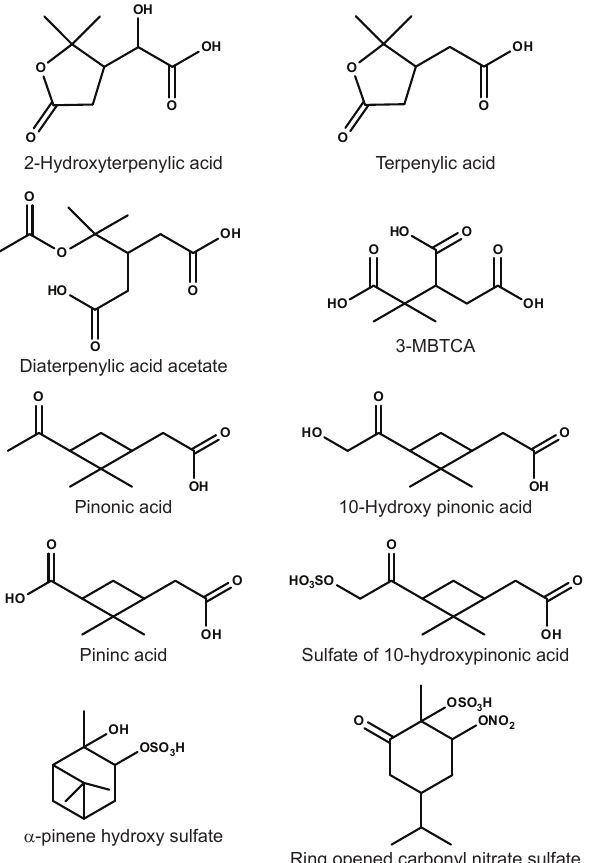
Fig. 4. Structures of identified SOA components detected by UPLC/(-)ESI-TOF.